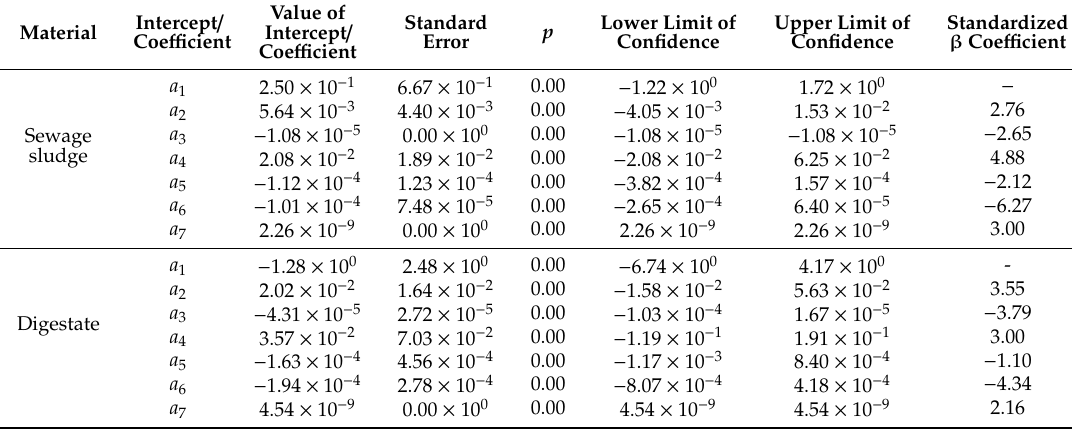
Table A1. Statistical evaluation of model coe ffi cients for the MY of CSF from sewage sludge and digestate. Material